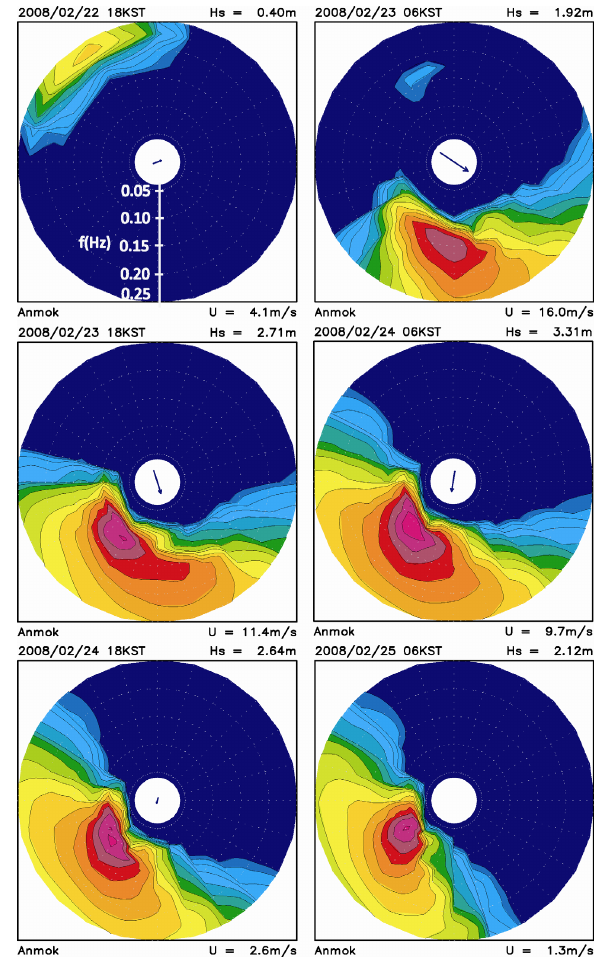
Fig. 18. As in Fig. 17, but at Anmok, Fig. 18. Calculated 2-D wave spectral plots Anmok, Korea, for the event of February 2008. Time and significant 3 wave height are shown above each panel, while wind speed and direction are shown below and in the centre of 4 each panel, respectively. The 16-level shaded colours represent wave energy density (m 2 /Hz) being doubled in 5 each level, with dark blue indicating the absence of wave energy (1.61238e-04) and light purple indicating a 6 local maximum (10.56695). Wave direction is toward the edge of the plot. 7